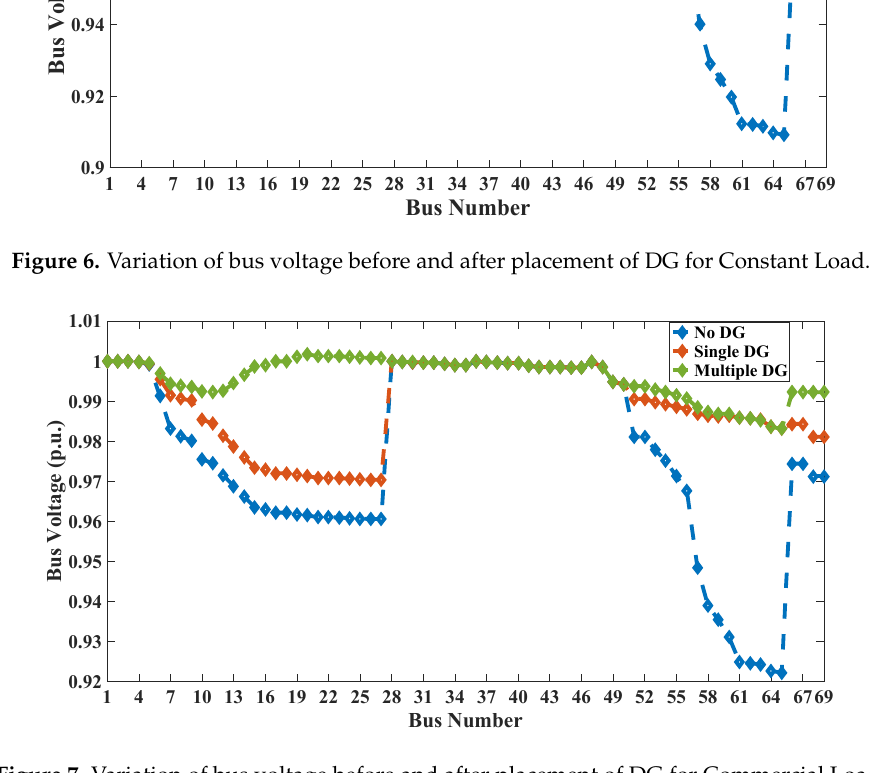
Figure 7. Variation of bus voltage before and after placement of DG for Commercial Load.